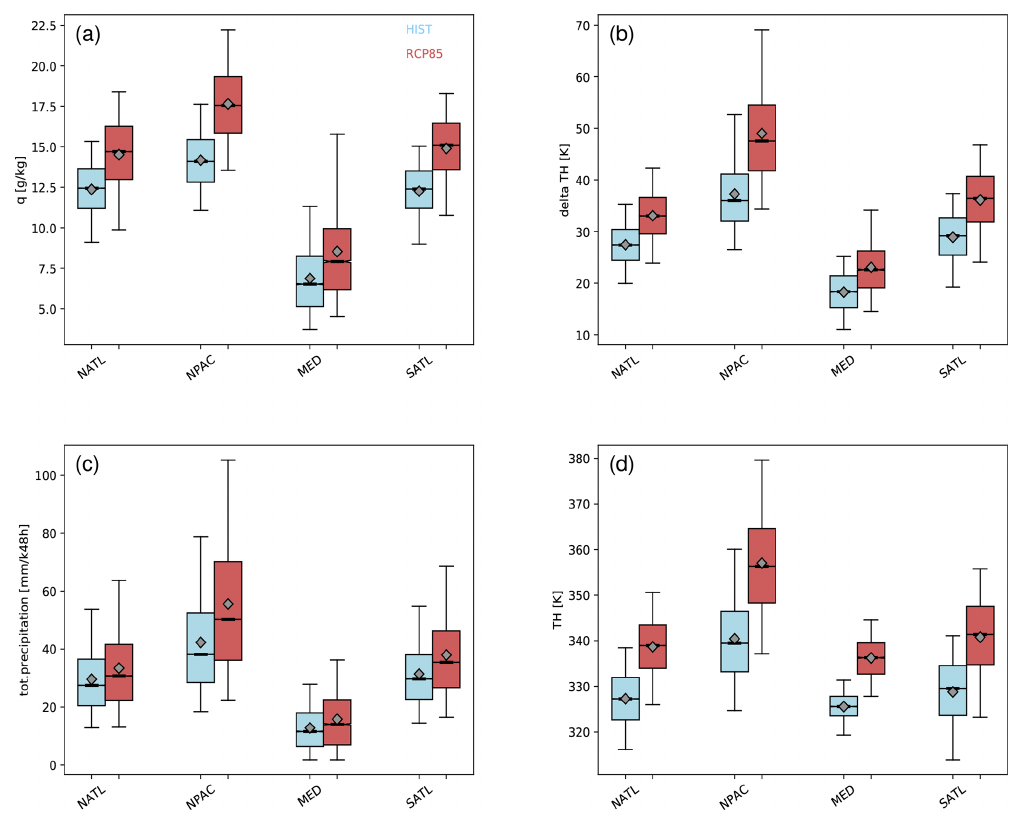
Figure 9. Same as Fig. 8 but for summer, i.e. JJA for NATL, NPAC, and MED and DJF for